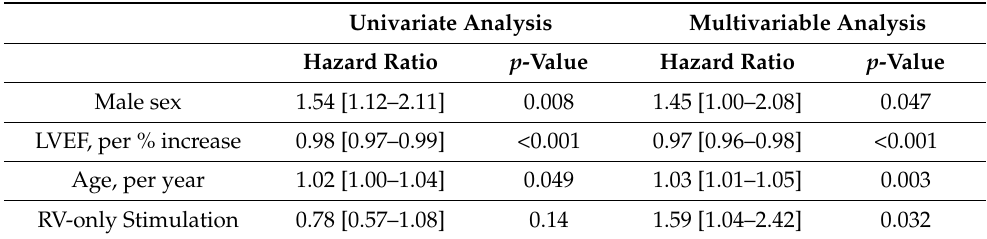
Table 3. Univariate and multivariable Cox regression analysis to predict the primary endpoint of death or HF